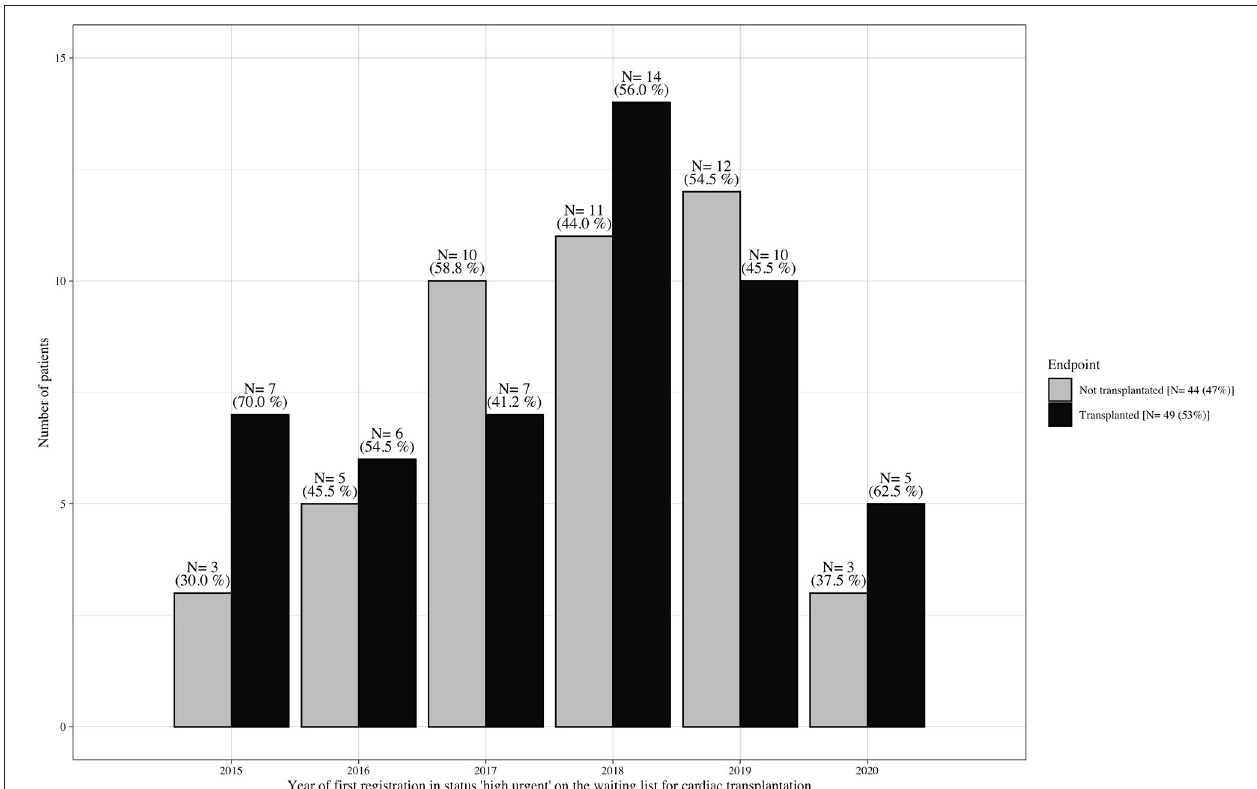
FIGURE 1 | Waiting list outcome at the German Heart Center Berlin (1/2015–10/2020). Number of patients per year who were listed without mechanical circulatory support in Eurotransplant status “high urgent” for cardiac transplantation and were consecutively transplanted vs. those who did not reach transplantation due to cardiac/clinical deterioration during the waiting time, resulting in death or emergency ventricular assist device